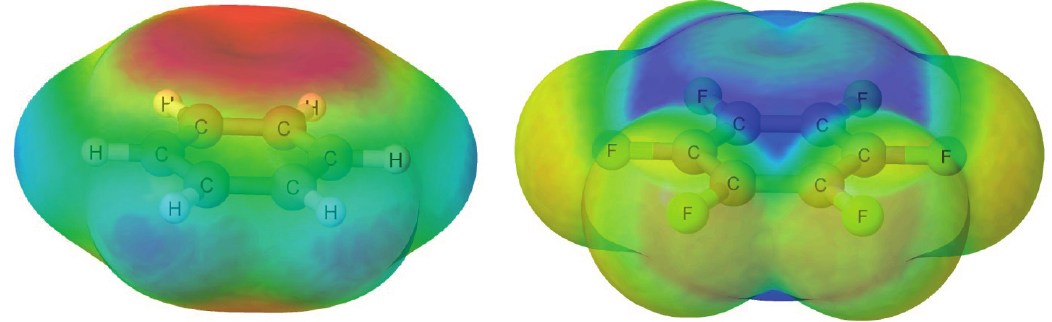
Figure 1. Electrostatic potential on the 0.001 au electron density of the isolated C 6 H 6 ( left ) and C 6 F 6 ( right ). The most intense red and blue color regions correspond to the − 0.02 and +0.03 au values, respectively.